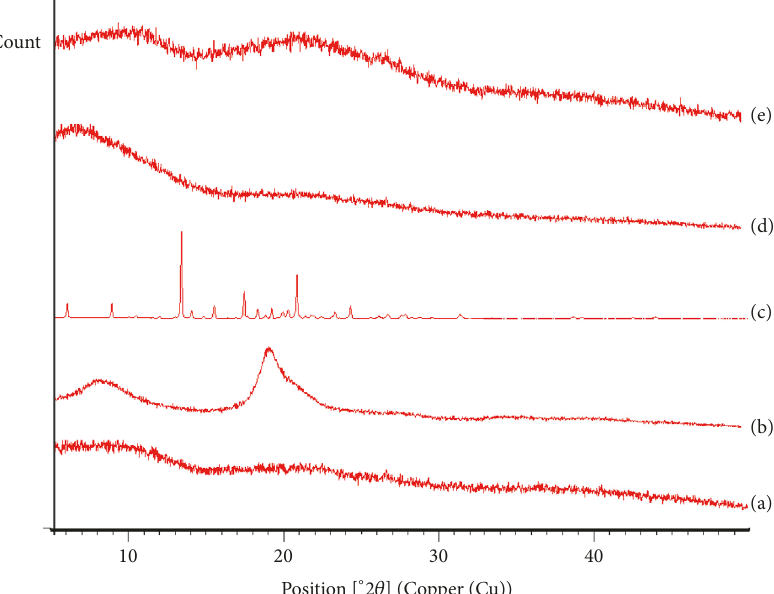
Figure 3: XRD of (a) FX, (b) CH, (c) TML, (d) blank nanoparticles, and (e) drug loaded optimized